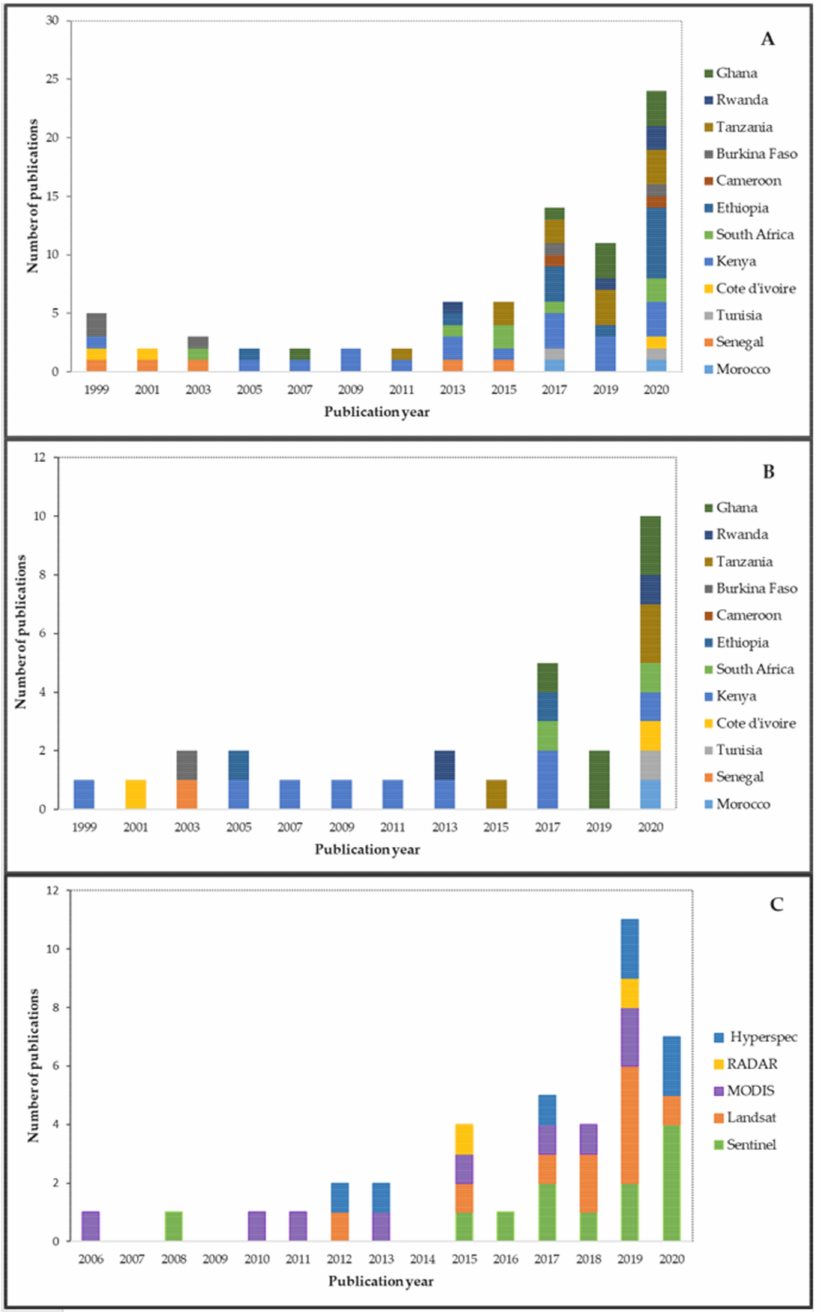
Figure 3. Stacked bar charts show the number of annual publications between 1998 and 2020 in Africa in the Scopus database that have: ( A ) “Yield gap” in their title, abstract, or keywords; ( B ) “Yield gap” and “at least one soil property” in their title, abstract, or keywords. ( C ) The primary platform or sensors used for the yield gap